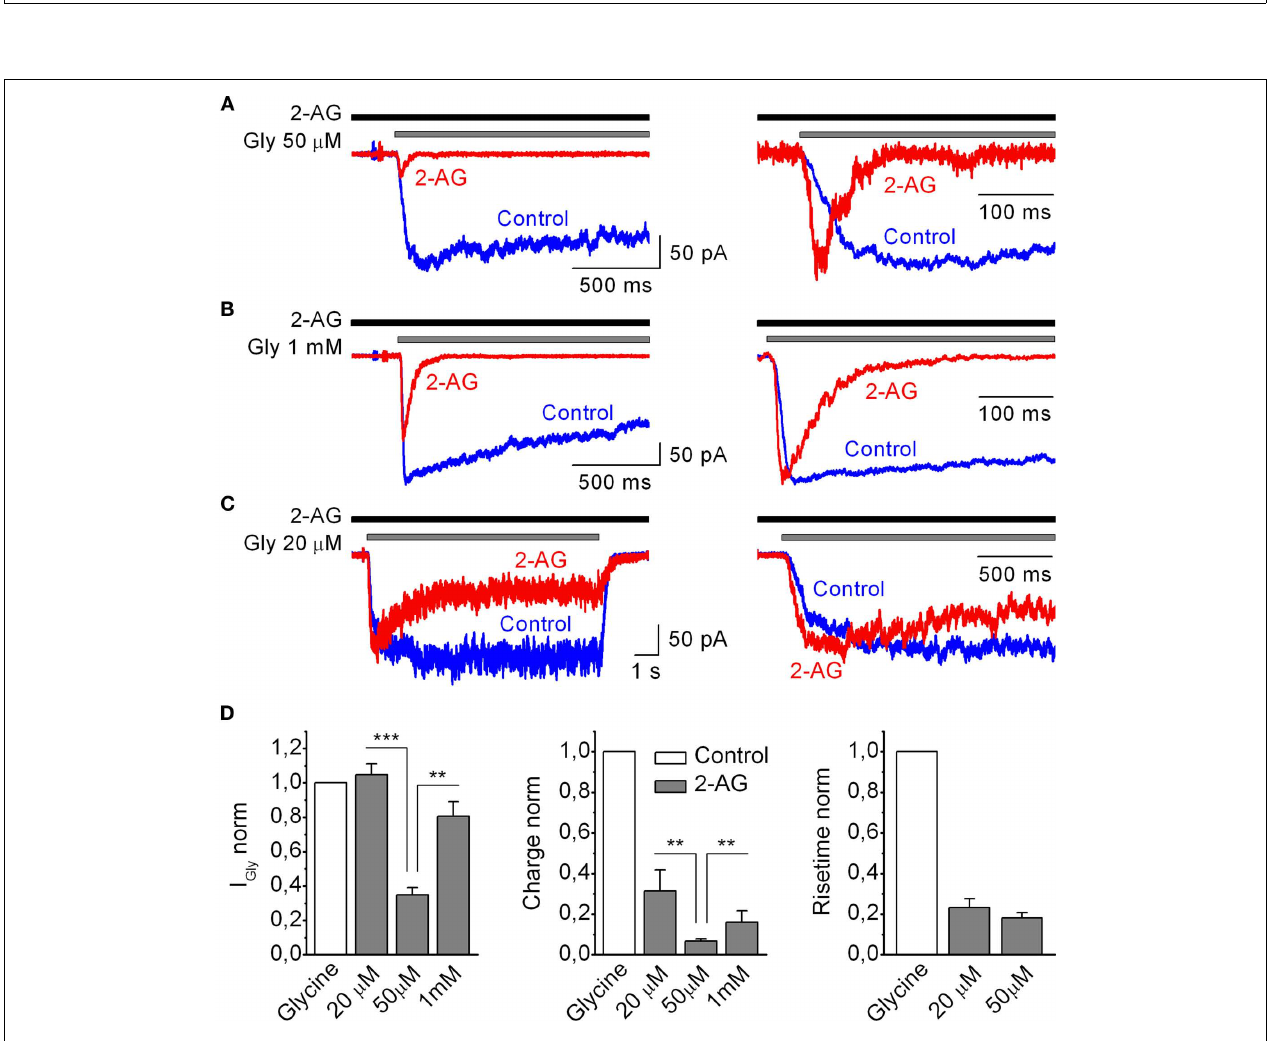
FIGURE 3 | Effect of 2-AG (1 μ M) on I Gly occurs within hundreds of milliseconds. (A) Representative traces of I Gly obtained in control (blue) and in the presence 2-AG (1 μ M, red) applied simultaneously with glycine (50 μ M).